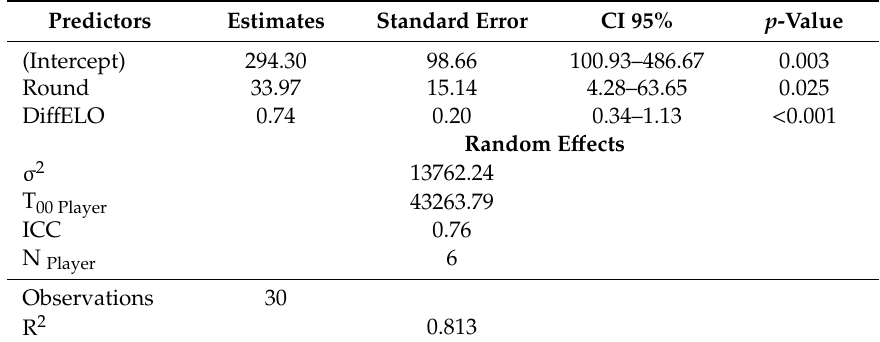
Di ff ELO = ELO Rating di ff erences between players; R 2 = determination coe ffi cient; σ 2 = CI Variance; ICC = intraclass correlation; CI = Confidence Interval; N = number of participants. T 00Player = variance of player’s random